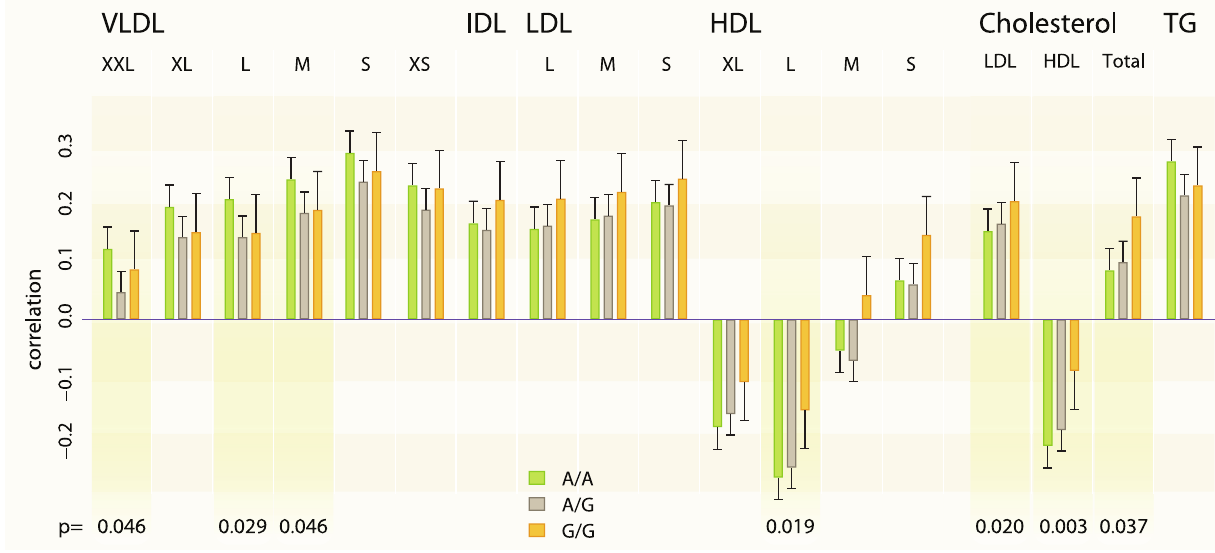
Figure 2. Lipoprotein subclass particle and key serum lipid concentration correlations with WHR for different genotypes of rs6448771. The height of the bar is the meta-correlation between the lipoprotein particle concentration and waist-to-hip ratio, and the whiskers correspond to standard error of the meta-correlation. The P -values have been taken from the interaction meta-analysis and only P -values , 0.01 are shown in the figure. The two cohorts in which the lipid particle concentrations were measured with NMR metabonomics platform were YFS and NFBC1966 with combined number of samples of 6,500. XXL_VLDL: Chylomicrons and extremely large very low-density lipoprotein particles; XL: Very large, L: large, M: Medium, S: Small, XS: Very small; VLDL: very low-density lipoprotein; IDL: intermediate-density lipoprotein; LDL: low-density lipoprotein; HDL: High-density lipoprotein; TG: Triglycerides; TC: Total cholesterol.